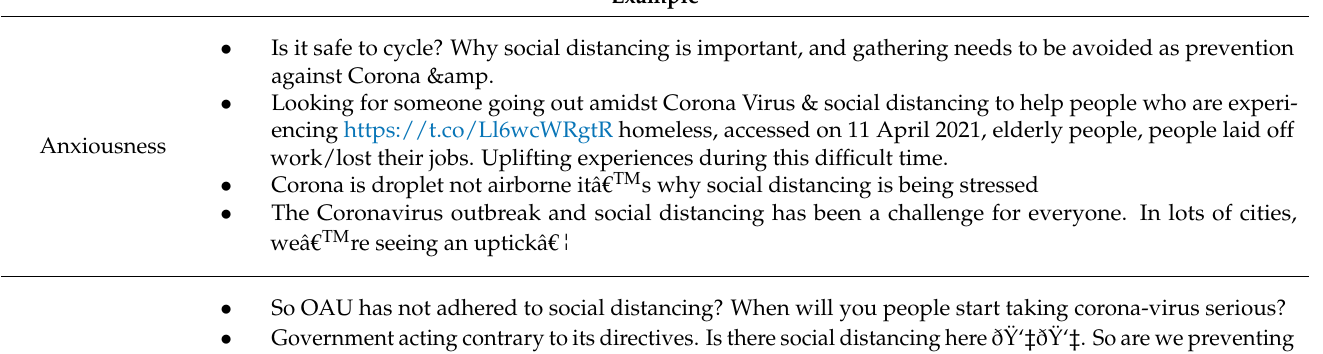
Table 1. Manually labelled sentiment categories with examples.